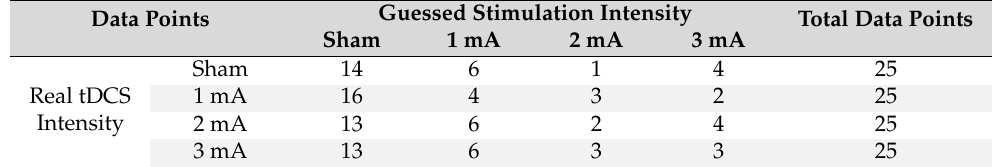
Table 3. Data points of guessed versus received tDCS intensity. After each session, participants filled in a questionnaire asking them to guess the intensity of applied tDCS (0, 1, 2, 3 mA). The table contrasts actually applied (rows) with perceived stimulation intensities